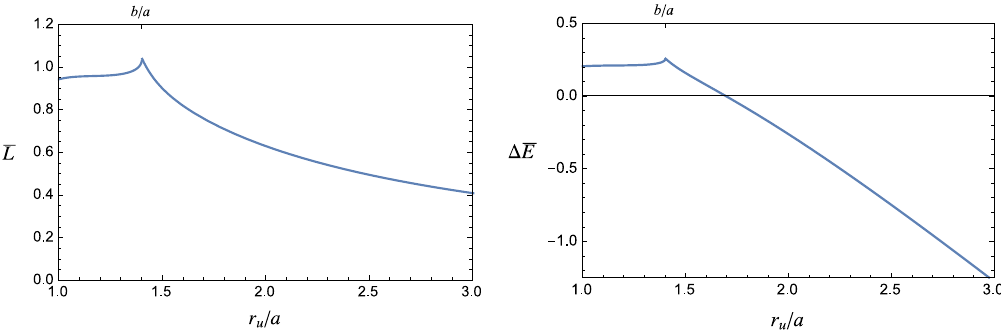
Figure 2 . (cid:22) L and (cid:1) (cid:22) E as functions of the turning point r u =a